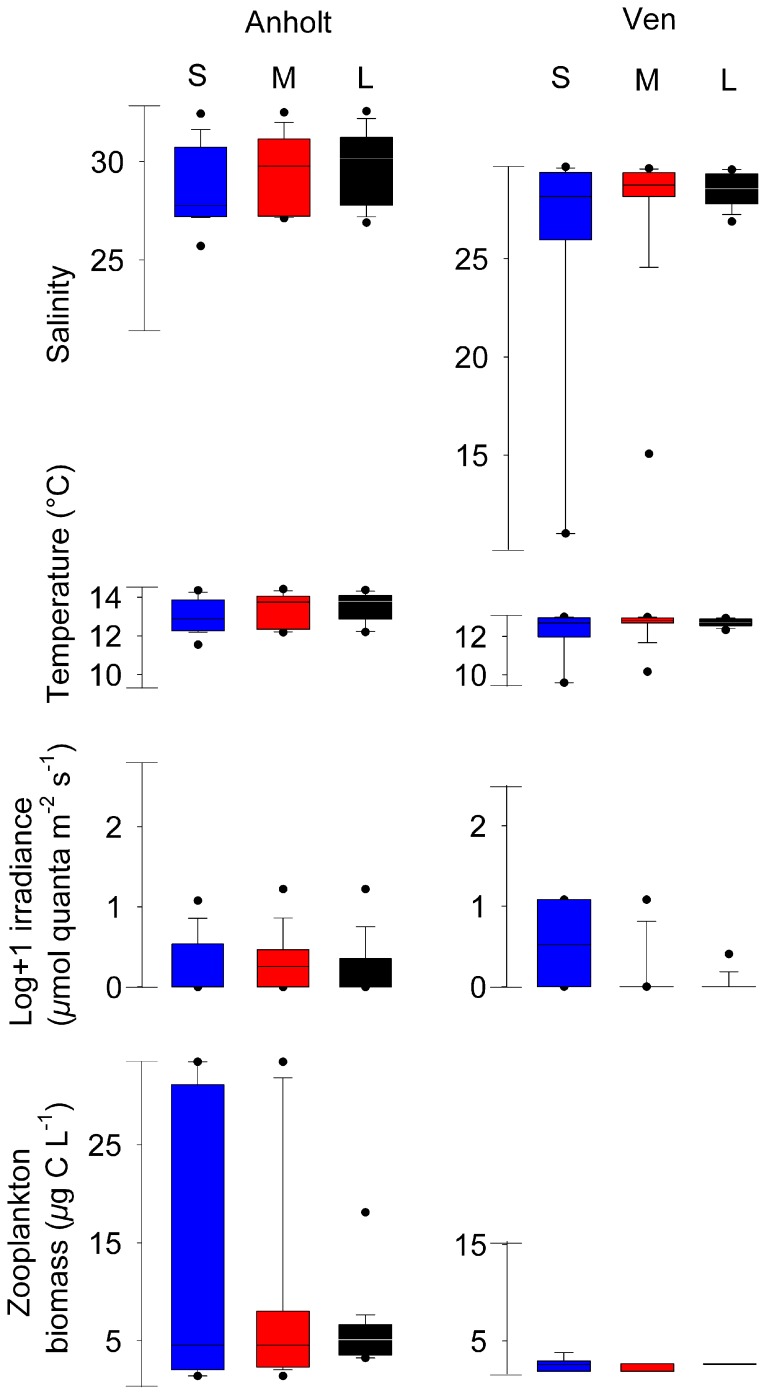
Observed environmental range.Distributions of environmental variables at Anholt and at Ven for three separate size classes of Mnemiopsis leidyi. Irradiance was only measured during daytime. The box represents 50% of all observations, with the solid line representing the median, the whiskers 10th and 90th percentile, and the dots the 5th and 95th percentile. Axes correspond to minimum and maximum of measured variables at the respective location. S = Small, M = Medium, L = Large. Small and medium individuals in Kattegat migrated.